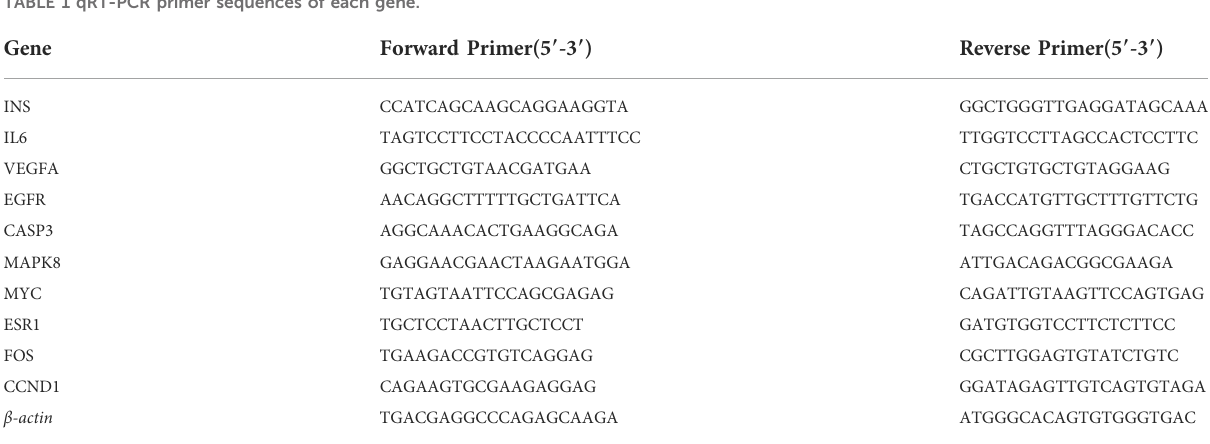
TABLE 1 qRT-PCR primer sequences of each